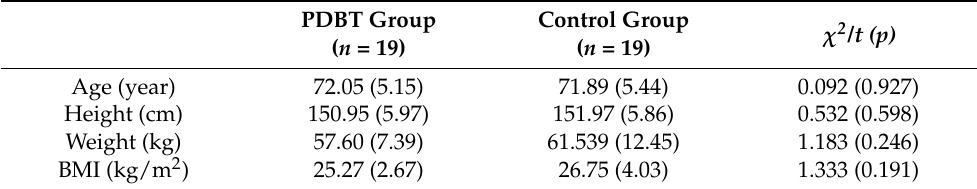
Table 1. Demographic data of the two groups ( n = 38).